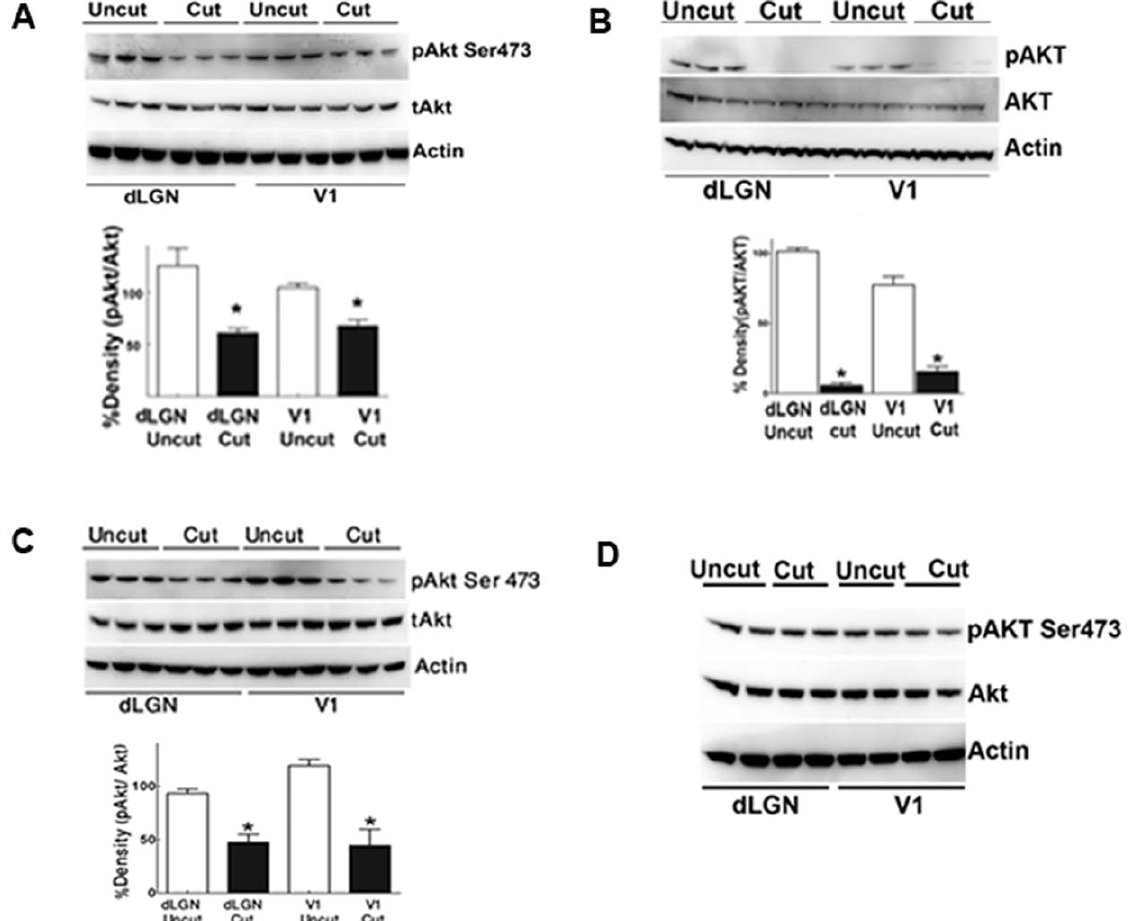
Figure 1. Western blots show the expression of pAkt/Akt in the dLGN and V1 from week 1 to month 2 (n=3 for each time point, n=2 for the sham). Actin was used as the loading control. Error bars represent SEM. (A) 1 week; (B) 1 month; (C) 2 months; (D) Sham.